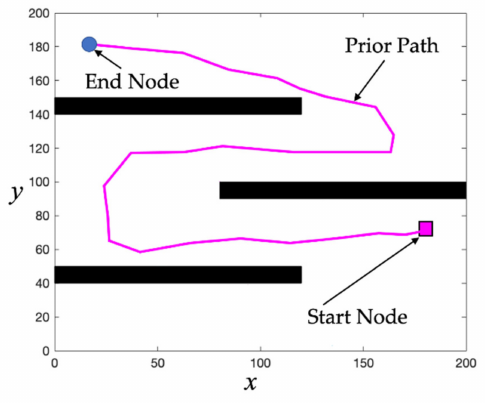
Figure 16. Case Study 2.